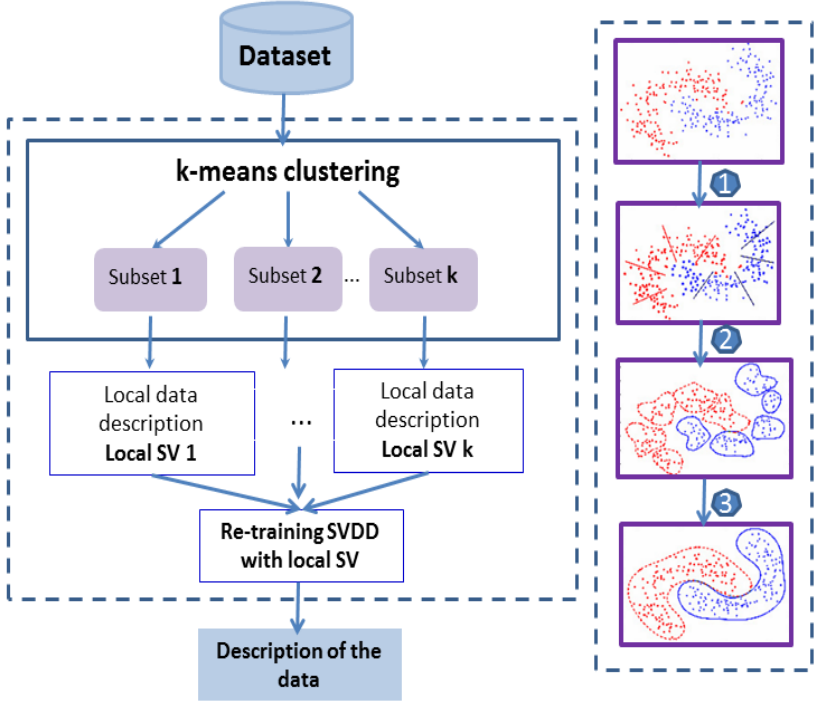
Figure 7. Outline of “divide and conquer” strategy for the division and training process based on the k-means clustering and SVDD sub-classifiers trained with only local support vectors (SV).